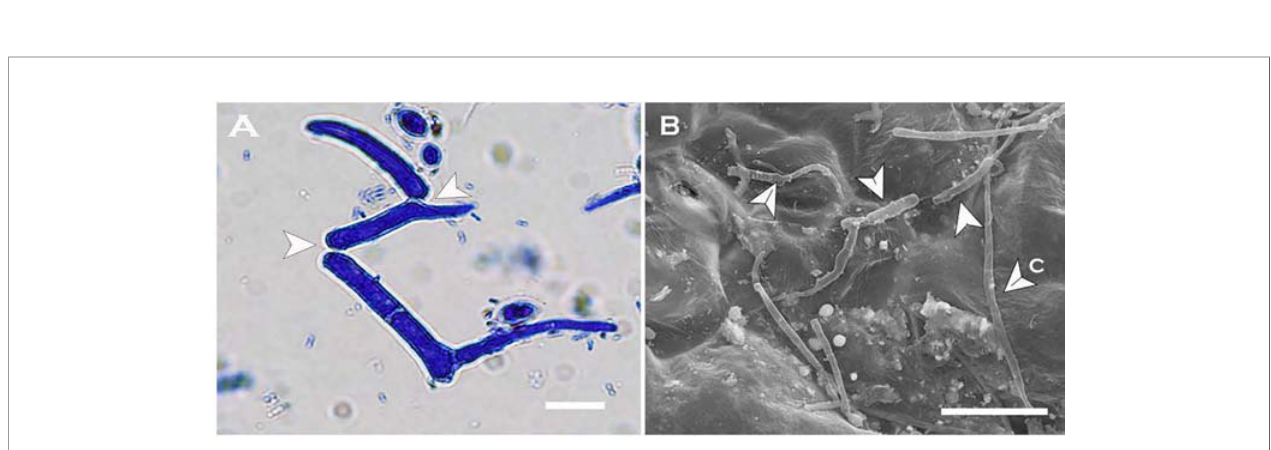
FIGURE 10 | Arthrospores produced by Neopseudocercosporella capsellae multi-celled macroconidia on the host. (A) Cylindrical arthrospore formation by disintegration of original macroconidia cell walls at septa (arrows) on the cotyledon surface as seen under the light microscope. (B) Scanning electron micrograph of multi-celled macroconidia (c) and germinating three arthrospores as single-celled spores by producing a single germ tube each (arrows) on the cotyledon. Scale bars = 10µm.